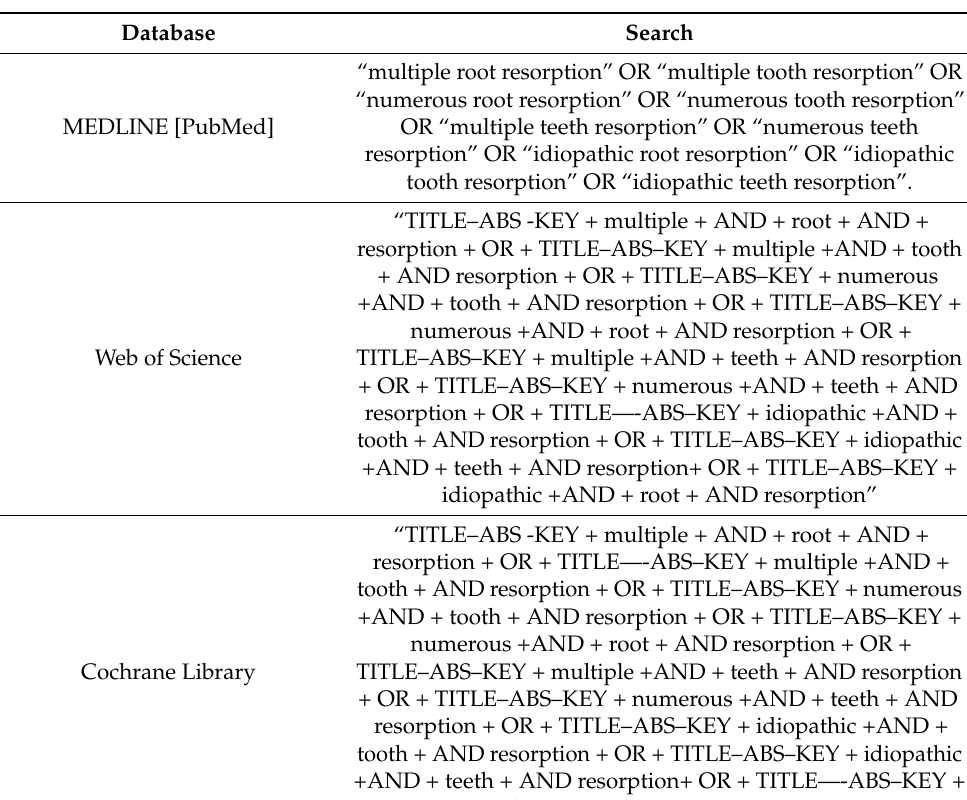
Table 1. Electronic database and search strategy (9 January